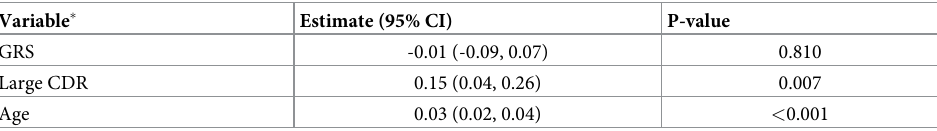
Table 4. Linear regression model estimates of 3MSE